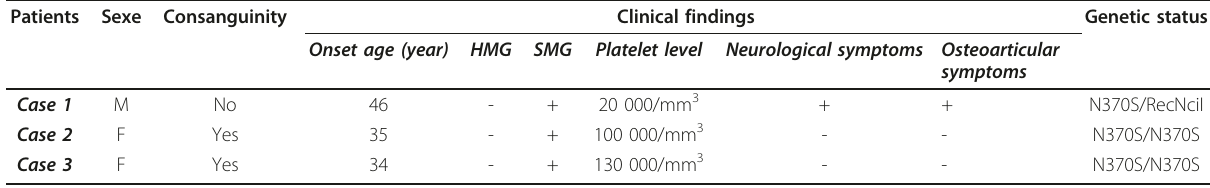
Table 1 Clinical and genetic features of 3 Tunisian GD patients. Patients Sexe Consanguinity Clinical